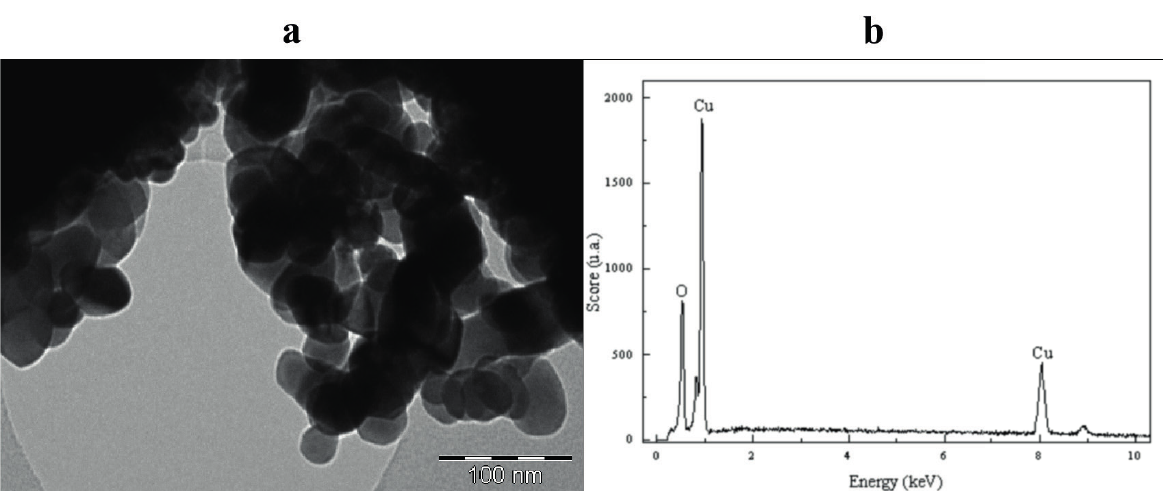
Figure 1. ( a ) Transmission electron microscopy micrography and ( b ) EDS spectrum of CuO